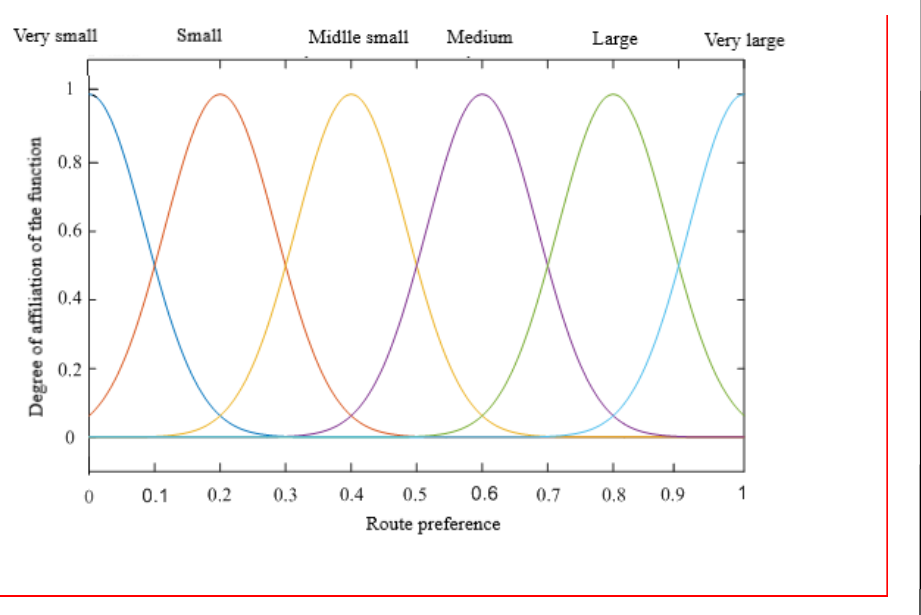
Figure 3 – Output variable membership functions Рис. 3 – Функции принадлежности выходных переменных Слика 3 – Функције припадности излазне